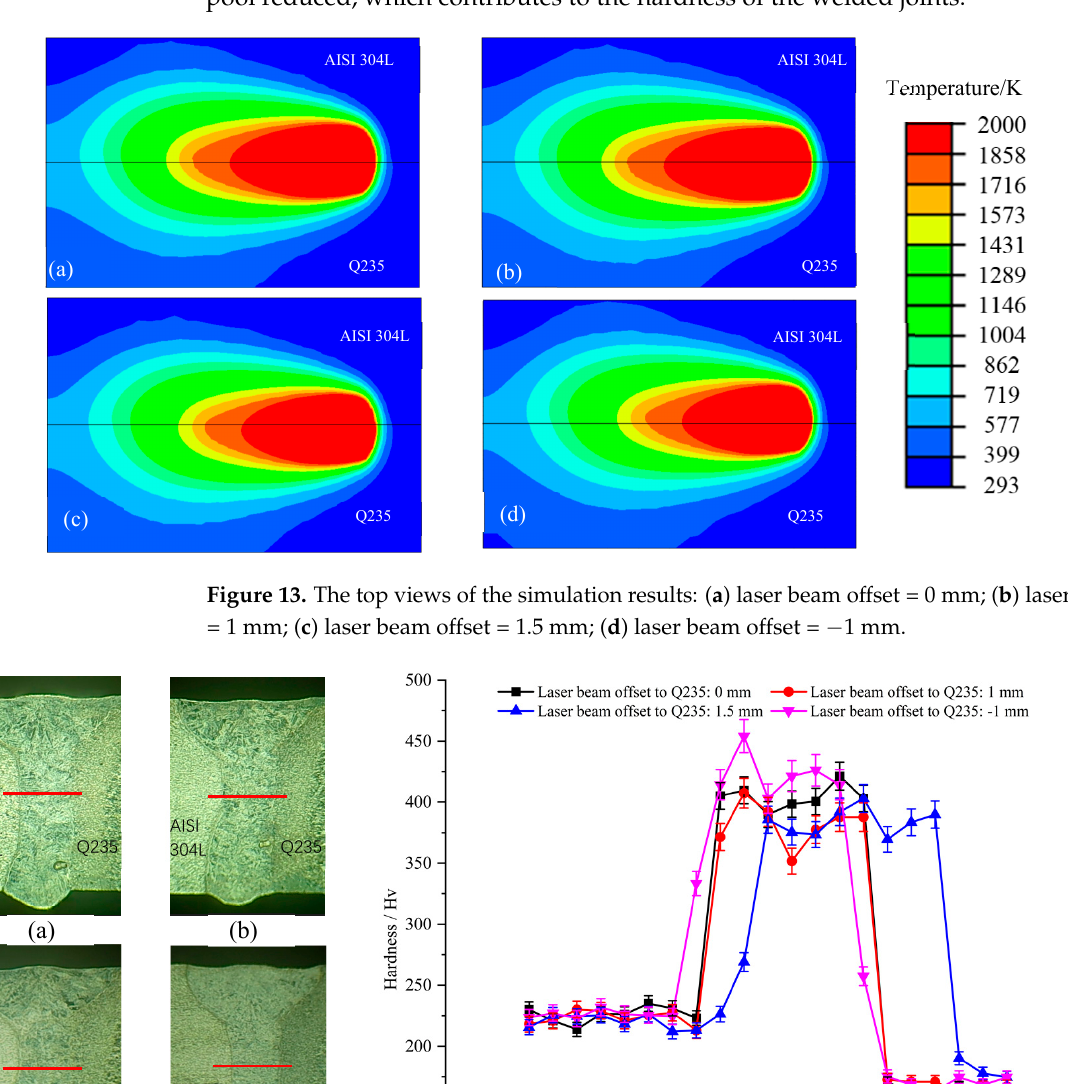
422 Figure 15. The tensile strength curves and fractured positions of samples with different laser beam offsets: ( a ) tensile strength curves; ( b ) laser beam offset = 0 mm; ( d ) laser beam offset = 1 mm; ( d ) laser beam offset = 1.5 mm; ( e ) laser beam offset = − 1 mm. 6. Conclusions In this study, the fiber laser butt welding of AISI 304L and Q235 was performed. A numerical simulation model with an integrated heat source combined with an asymmetric double-ellipsoidal heat source and a cylindrical heat source was established to study the thermal circle of the weld. The conclusions of this study are as follows: